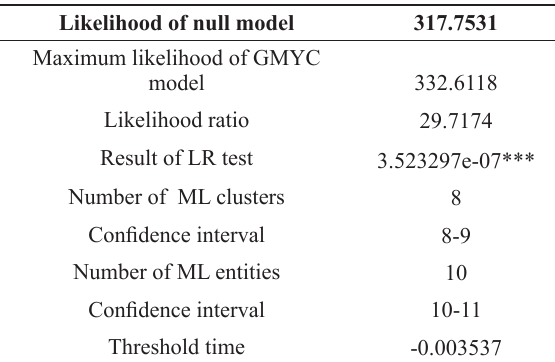
Result the GMYC test for molecular delimitation of OTUs of